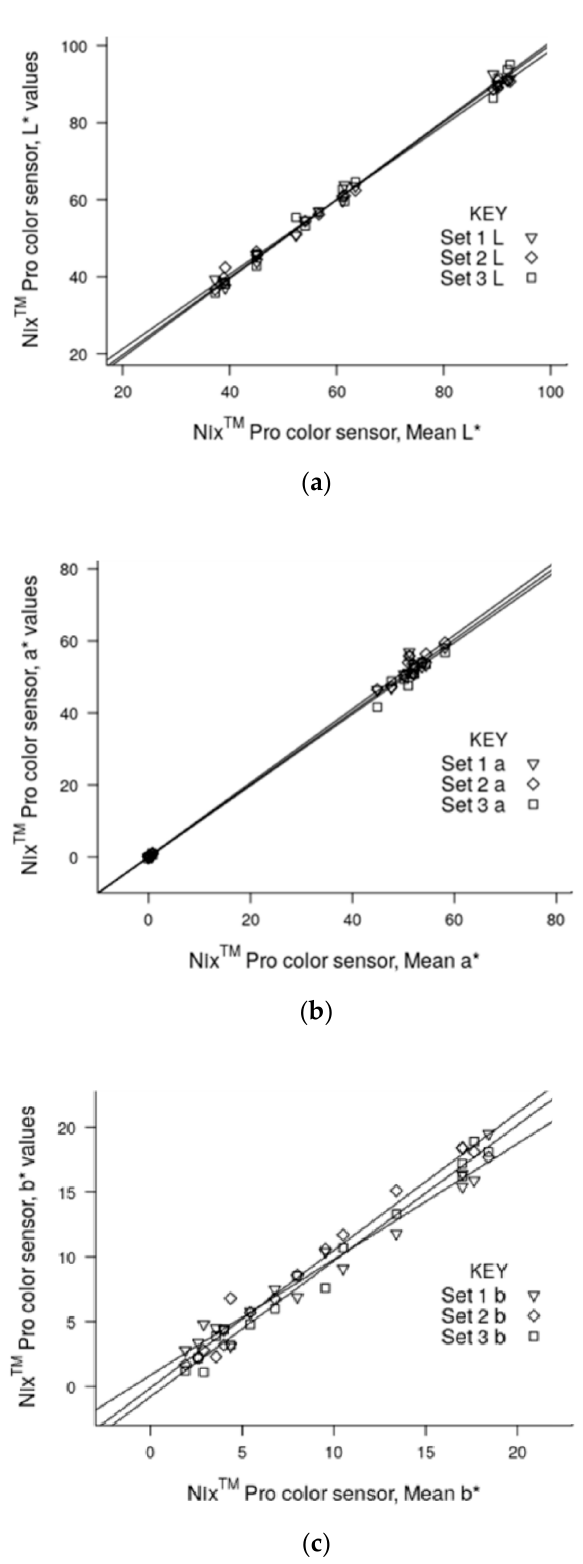
Figure 5. Comparison of Nix TM Pro sensor color values to Royal Horticultural Society (RHS) Colour Chart published values for: ( a ) L* (darkness to lightness), ( b ) a* (redness to greenness), and ( c ) b* (yellowness to